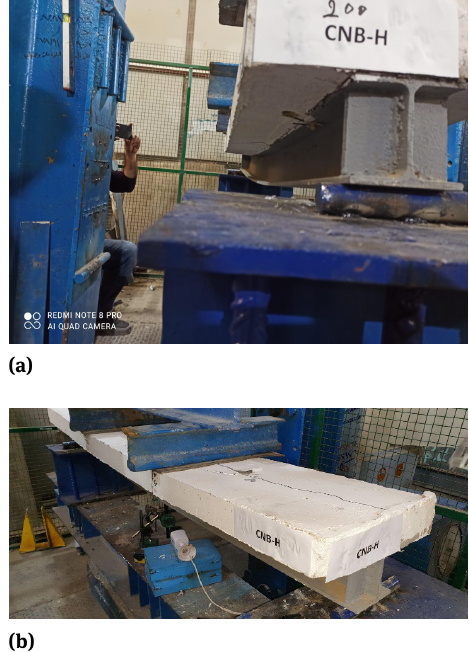
Figure 13: Failure mode of Specimen CNB-H